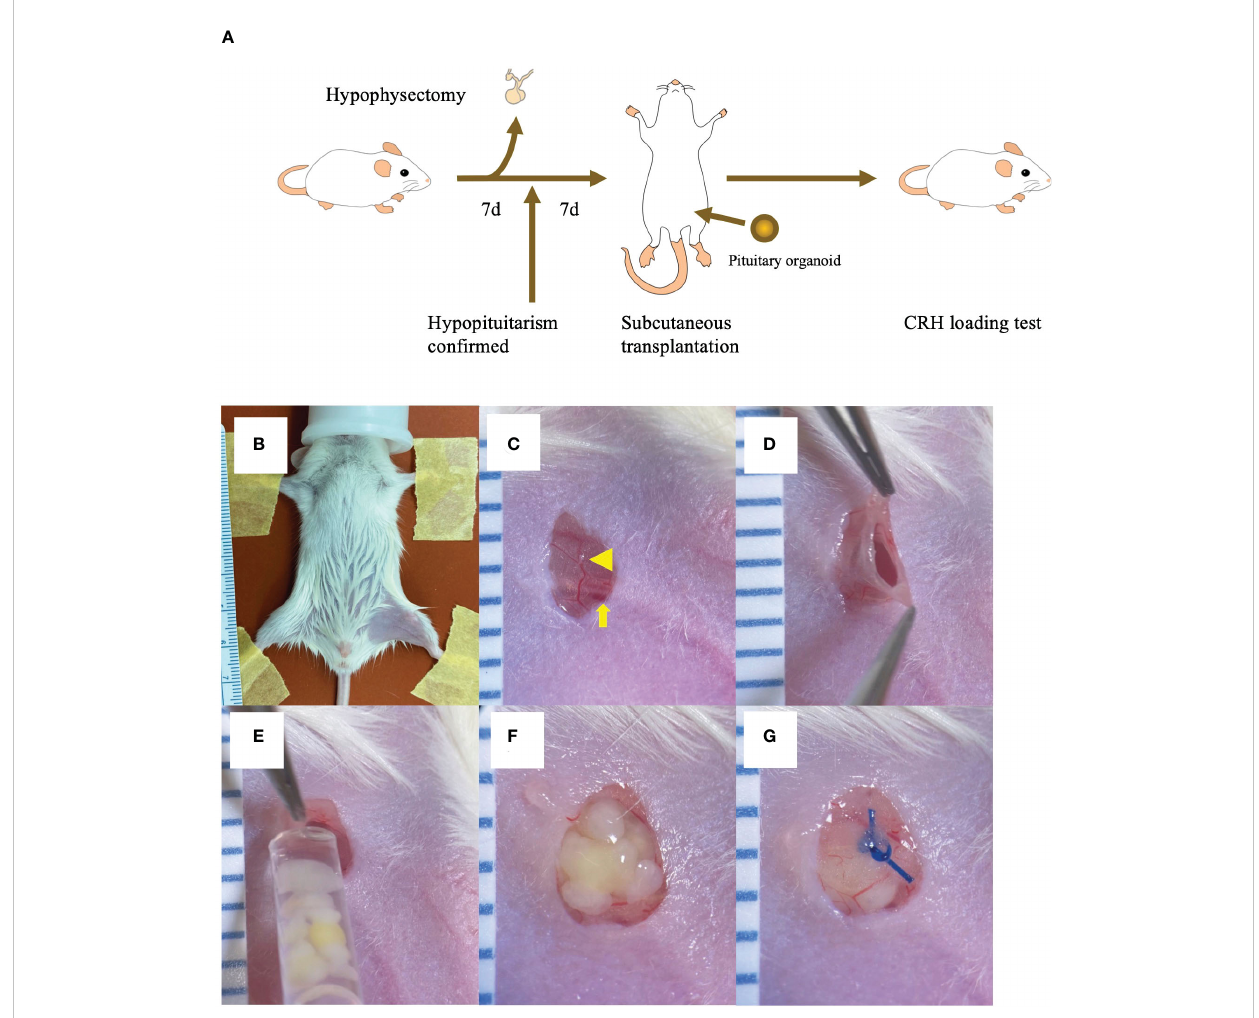
FIGURE 1 Inguinal subcutaneous white adipose tissue (ISWAT) transplantation of hESC-derived pituitary organoids (POs) (A) Schema, mouse handling protocol (hypophyseal ablation, con fi rmation of hypopituitarism, POs transplantation, and allograft-function testing). (B) Shaved left inguinal area, restrained supine mouse under inhalation anesthesia. (C) Vessel in fi lmy adipose tissue (arrowhead) overlying femoral vein and artery (arrowhead) viewed through 4mm vertical skin incision. (D) Pocket created in ISWAT. (E) POs emplacement into pocket via syringe fi tted with wide-bore tip. (F) Emplaced POs. (G) Nylon suture closure of adipose tissue over POs. Scale intervals,